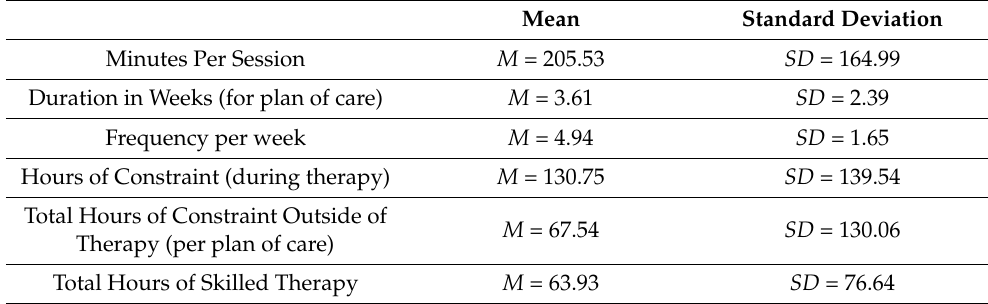
Table 3. Frequency, Intensity, Duration of Intervention.